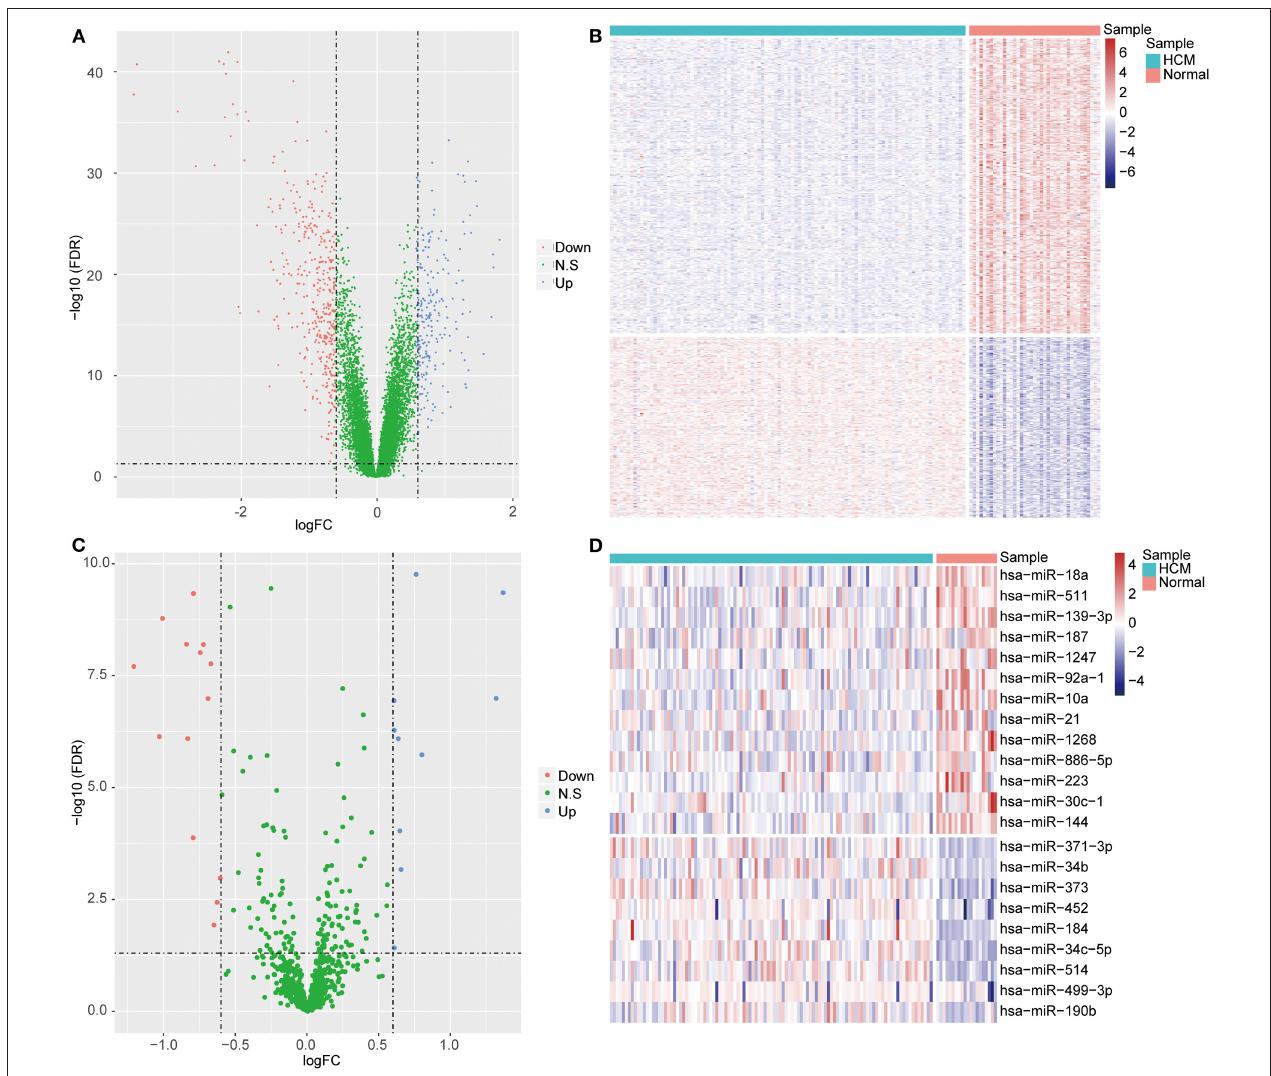
FIGURE 1 | Differentially expressed mRNAs (DEGs) and miRNAs (DEMs) between HCM samples and healthy controls. (A) Volcano plot of DEGs in GSE36961. The x axis represents log 2 FC of differential expression values, the y axis represents –log10 (FDR), blue dots represent upregulated mRNAs, and red dots represent downregulated mRNAs. (B) Heatmap of DEGs in GSE36961. The x axis represents samples, and the y axis represents genes. (C,D) The volcano plot (C) and heatmap (D) of DEMs from GSE36946